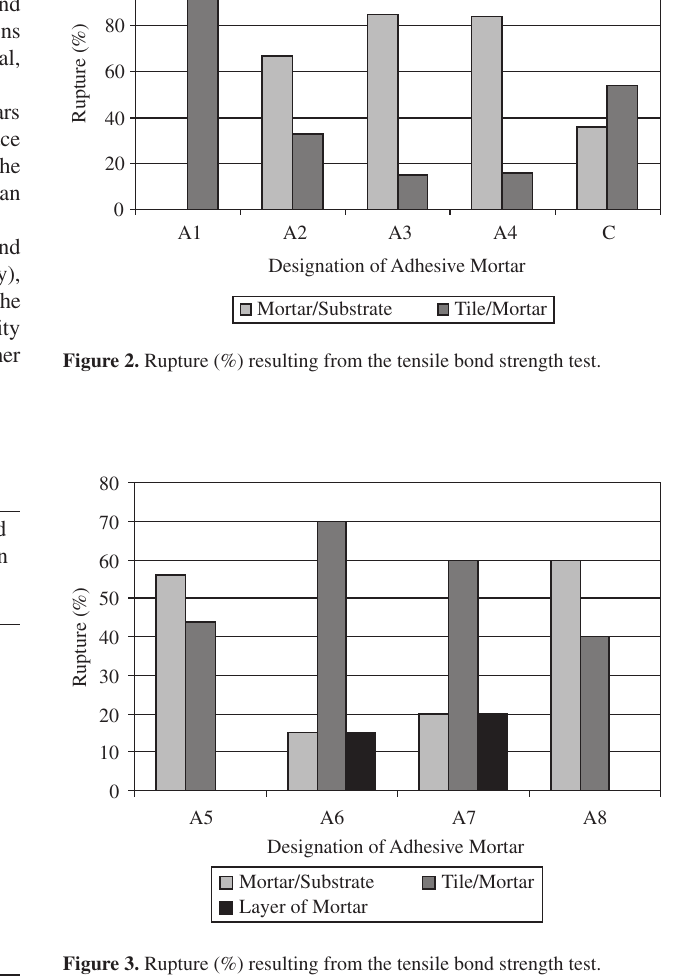
Figure 3. Rupture (%) resulting from the tensile bond strength